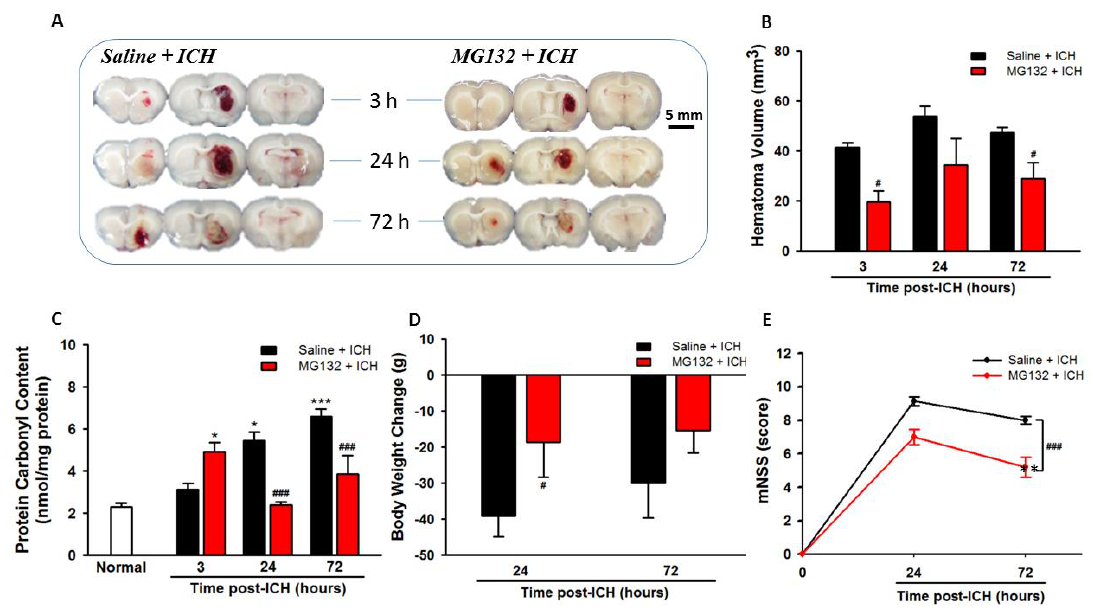
Figure 1. MG132 pre-treatment reduced hematoma volume, oxidative stress, body weight loss, and neurological impairments of intracerebral hemorrhage (ICH) rats. Representative image of hemorrhagic brain sections in ICH and MG132 pre-treated-ICH rats at 3, 24, and 72 h post-ICH injury ( A ). Statistical hematoma expansion volume ( B ), protein carbonyl content ( C ), body weight change ( D ), and modified Neurological Severity Score (mNSS) neurobehavioral assay ( E ) at 0 (normal), 3, 24, and 72 h post-ICH; respectively. Values are indicated by means ± SEM; n = 6 each group, * p < 0.05; *** p < 0.001; compared to the normal group; # p < 0.05; ### p < 0.001; compared to the Saline + ICH group, respectively.